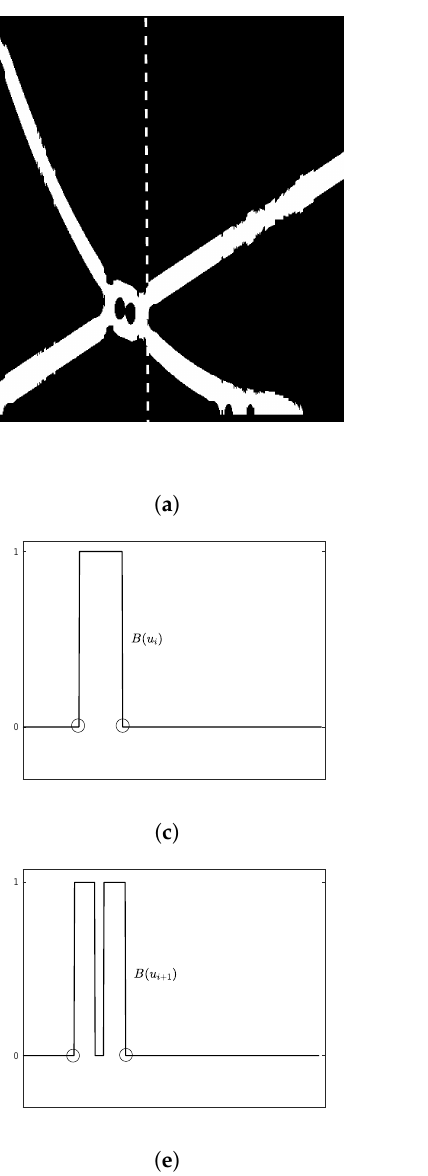
Figure 8. Binary map B where the considered columns are emphasized by the dashed line, concerning ( a ) a transition from separability region to interference region and ( b ) a new mode contribution. ( c – e ) Adjacent columns from ( a ). ( d – f ) Adjacent columns from ( b